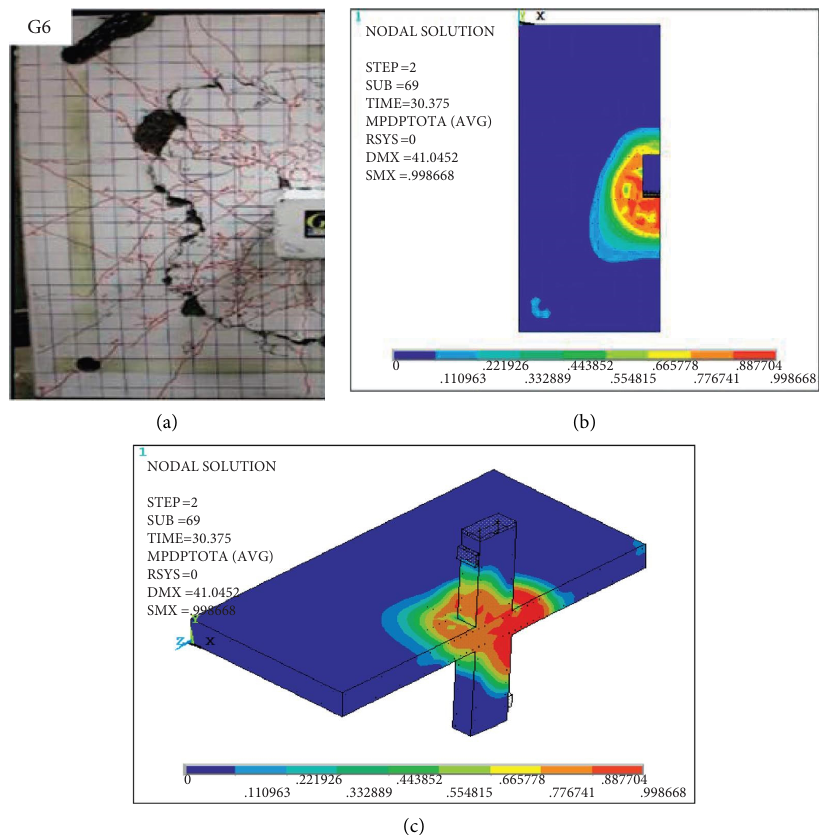
Figure 23: Comparison of concrete damage of specimen G6CS-2d at failure load. (a) Experimental half-scale [8]. (b) FEA half-scale plan view. (c) FEA half-scale 3D view.